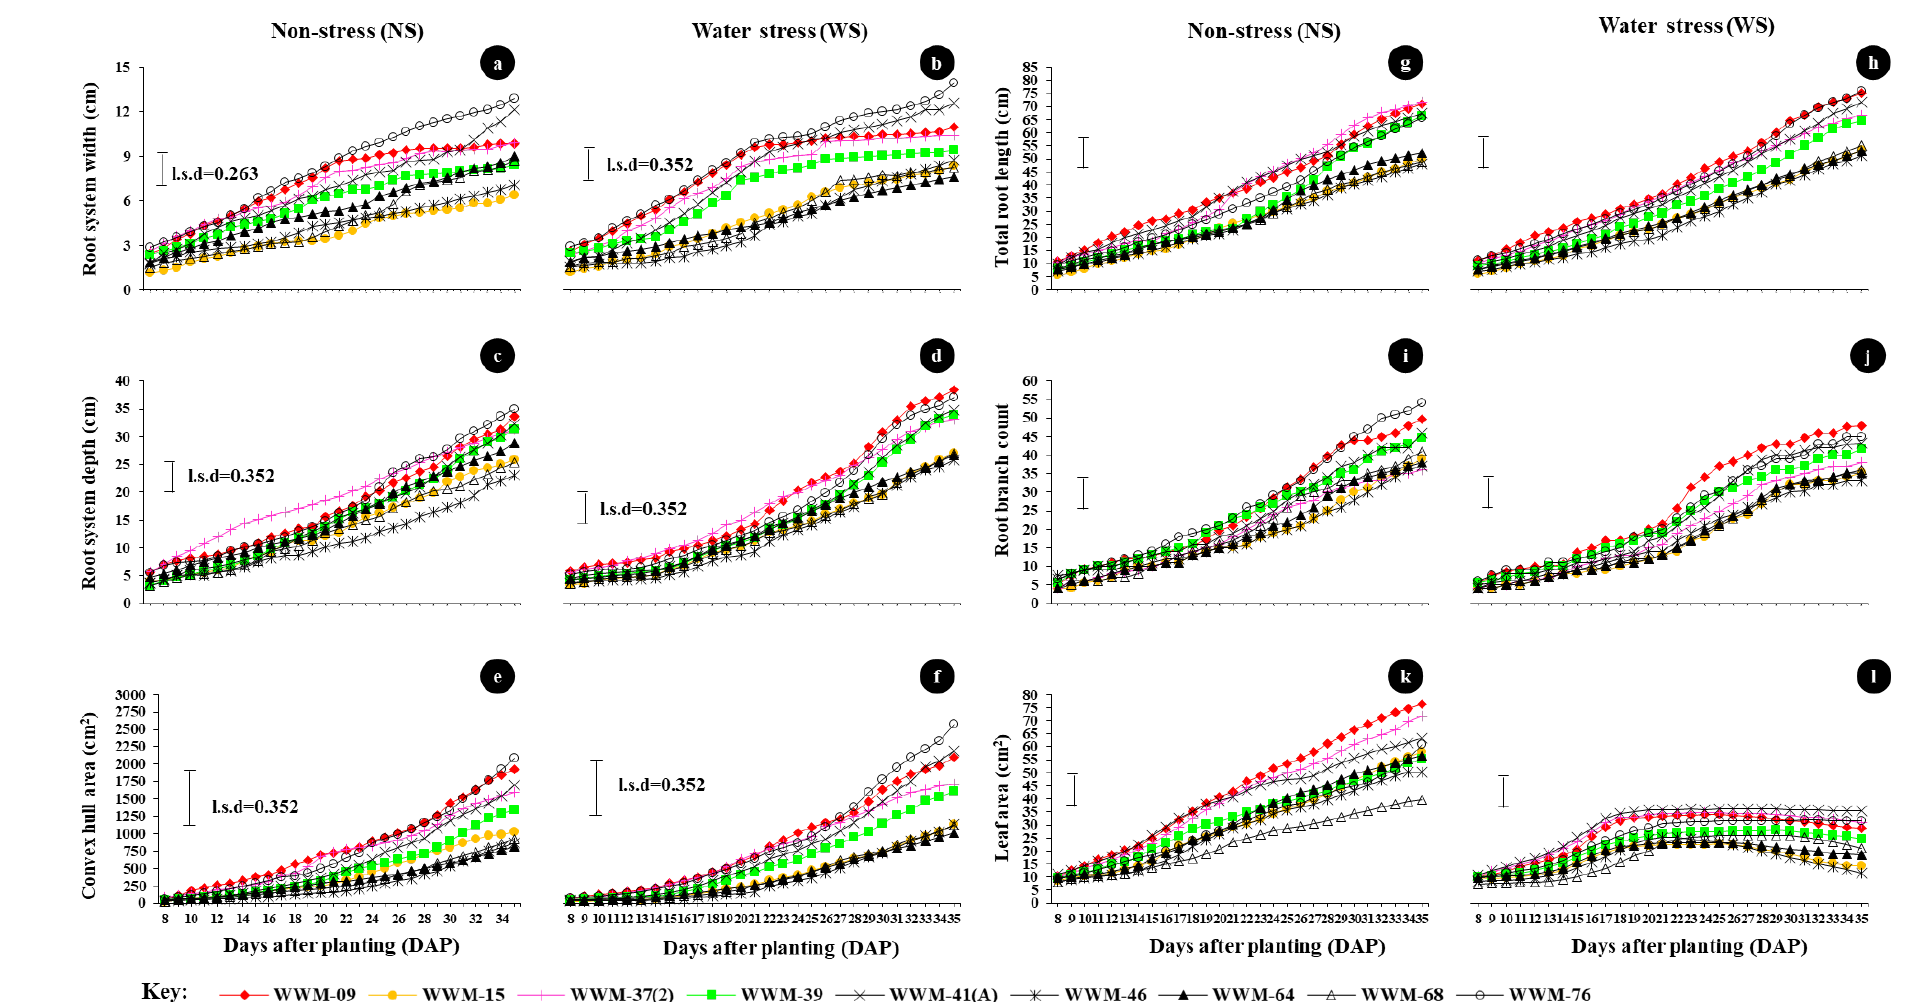
Figure 2. Changes in root growth and leaf area of nine drought-tolerant citron watermelon accessions under non-stressed and water stress conditions from 8 to 35 days after planting.